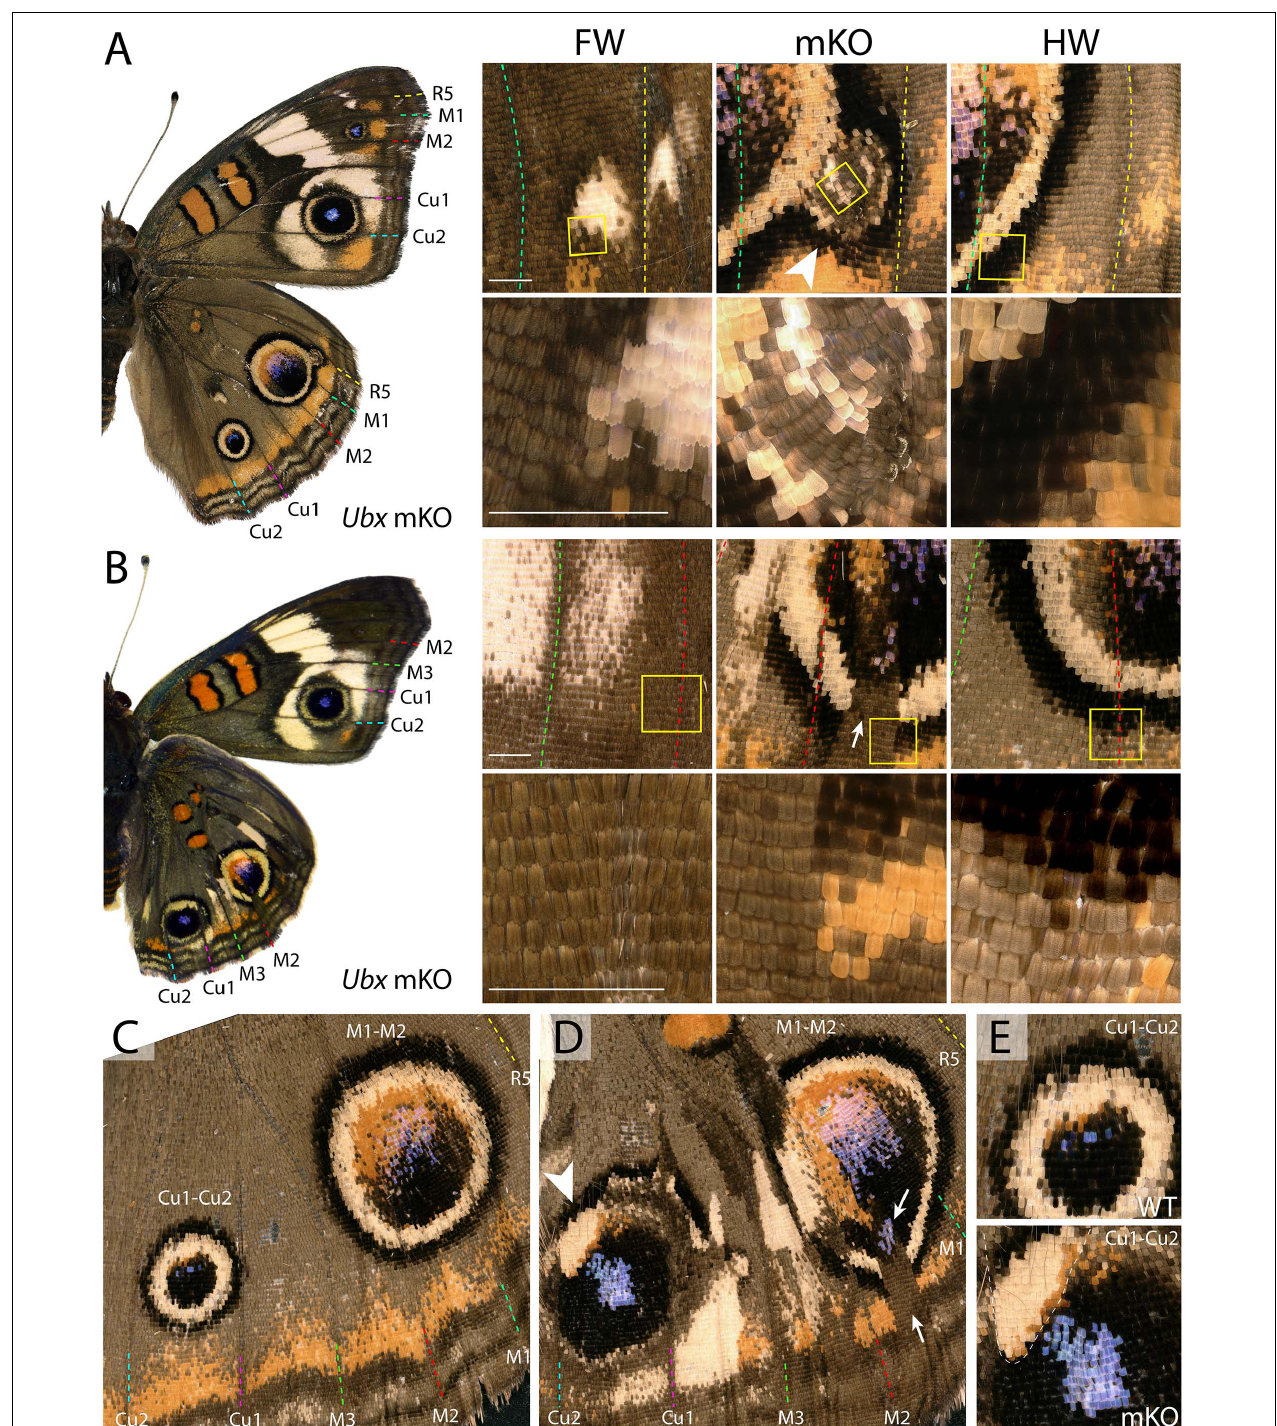
FIGURE 2 | Variegated effect of partial mKO in the Junonia eyespot fields. (A) Ectopic R5-M1 eyespot appearing as a satellite to a WT M1–M2 eyespot, and forming rings not observed in the forewing (arrowhead). Lower panel depicts magnification of yellow insets in the upper panels. (B) Mosaic mutant with a complete Cu1–Cu2 eyespot homeosis, and partial mutant clones in the M1–M2 eyespot (insets). Arrow: missing outer rings and orange distal parafocal element in a mutant clone. (C) Magnified view of a WT hindwing (inset in E, upper panel : Cu1–Cu2 eyespot) (D) Equivalent view of a mosaic KO with partial Cu1–Cu2 and M1–M2 eyespot phenotype. Arrow: missing outer rings and orange distal parafocal element in a mutant clone; arrowhead: residual outer rings in a WT clone. Inset in (E, lower panel): magnified view of the Cu1–Cu2 eyespot, with residual outer rings in wild-type tissue (upper left, dashed line). Scale bars = 500 µ m.